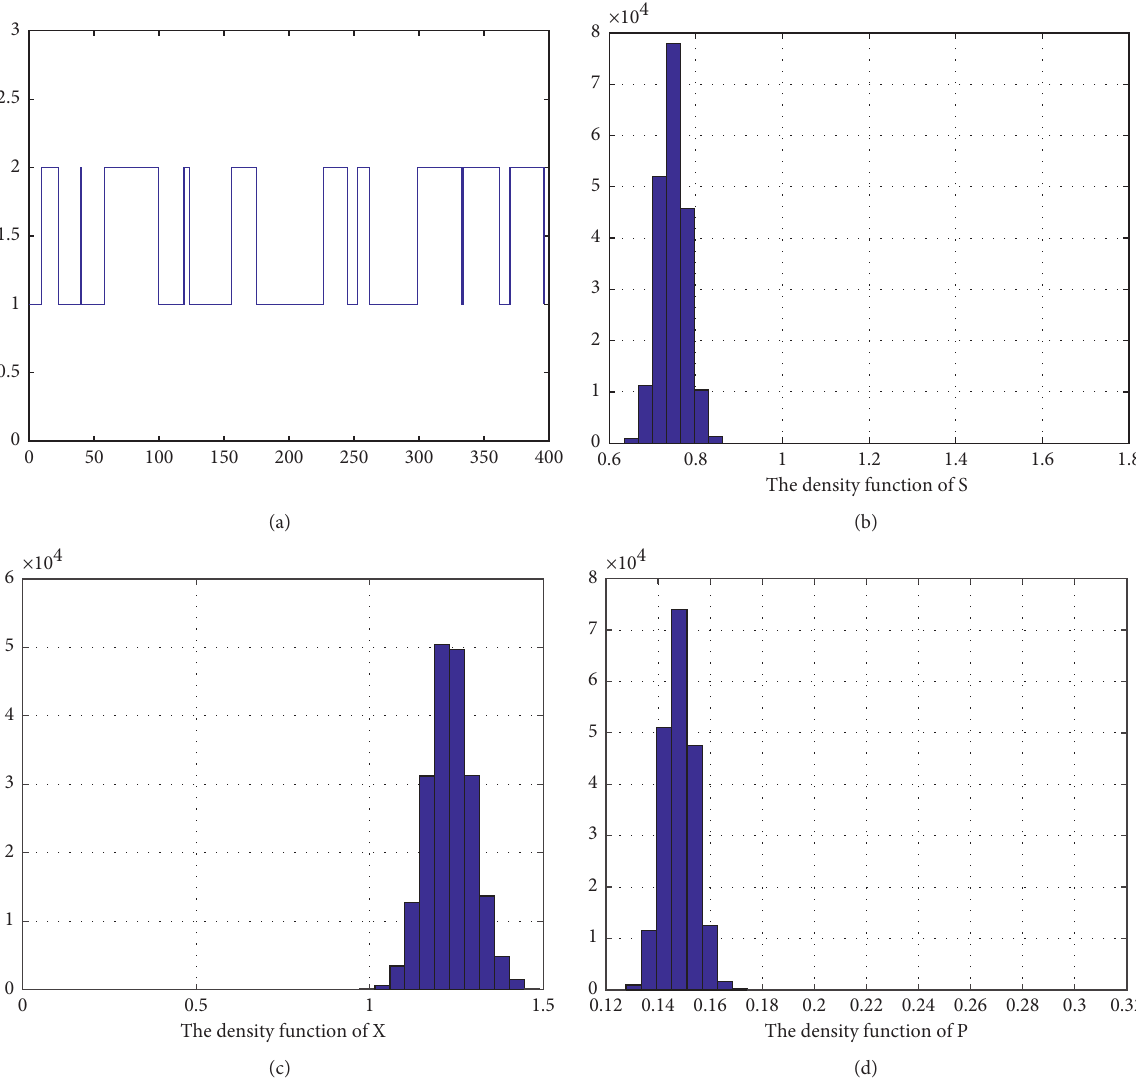
Figure 1: Numerical simulation of system (4). (a) Markov chain, (b) the density function of S , (c) the density function of X , and (d) the density function of P